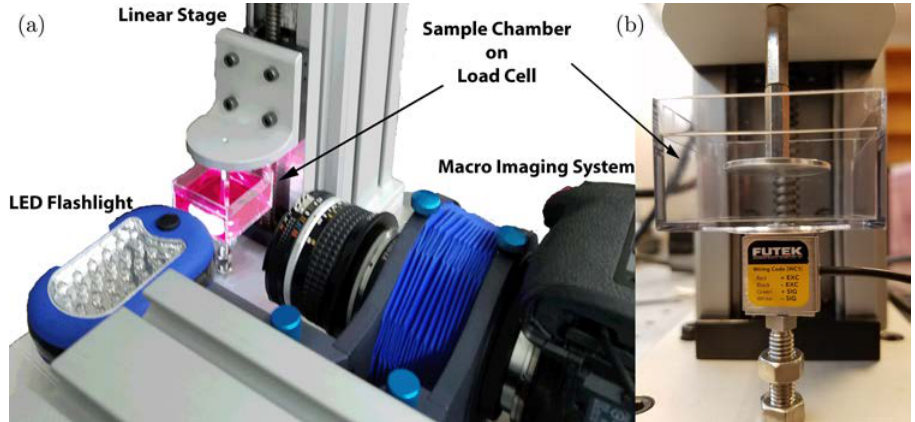
Fig. 1. (a) The lens compression apparatus and imaging system. The linear stage moves an aluminum plate vertically within the plastic sample chamber. (b): The sample chamber is mounted on the load cell, which is in turn rigidly connected to an